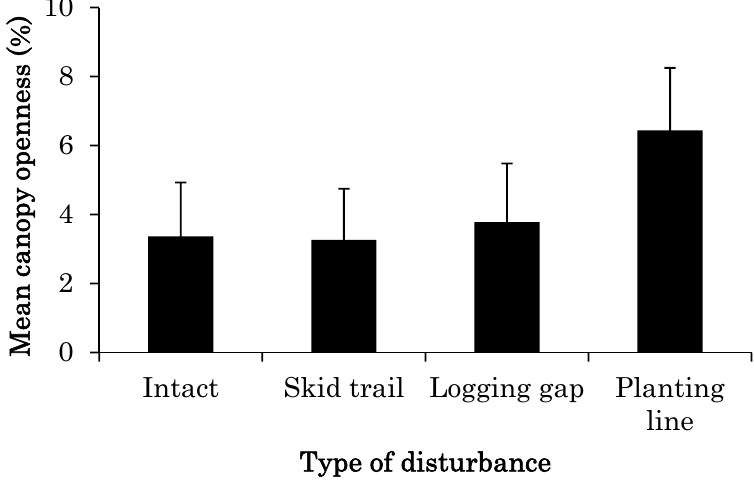
Figure 7. Mean O under each disturbance element measured at the SL site excluding plot SL3 in 2014. Error bars indicate the standard deviation.